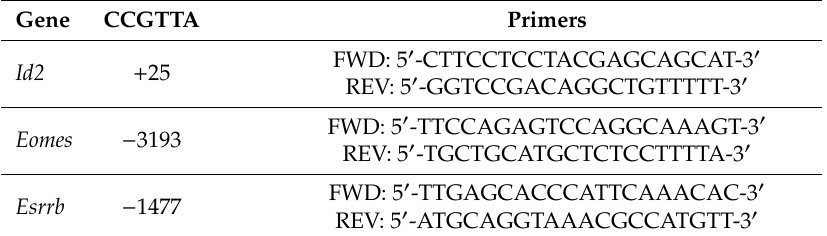
Table 2. Forward and reverse primers used for